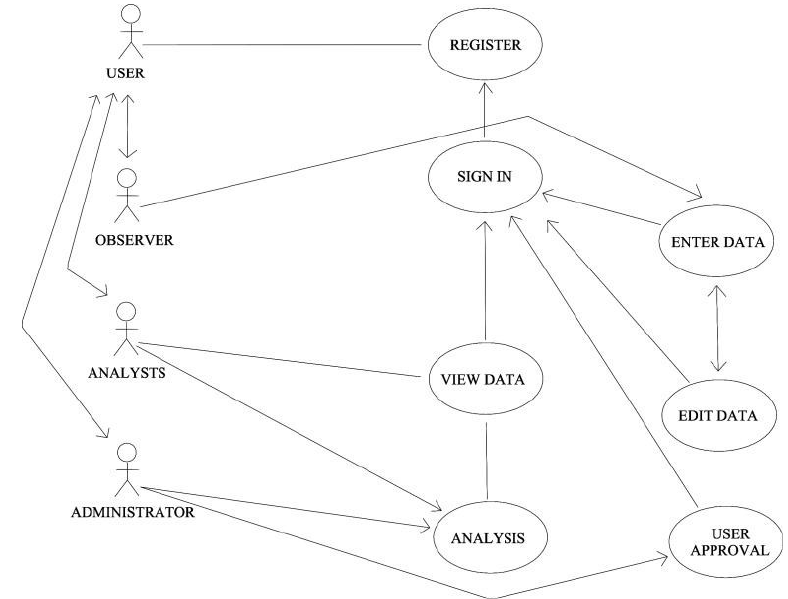
Figure 2. DRAES Usage Status